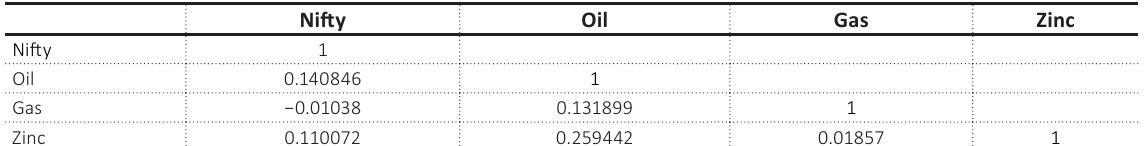
Table 3. Correlations of variables used in the study